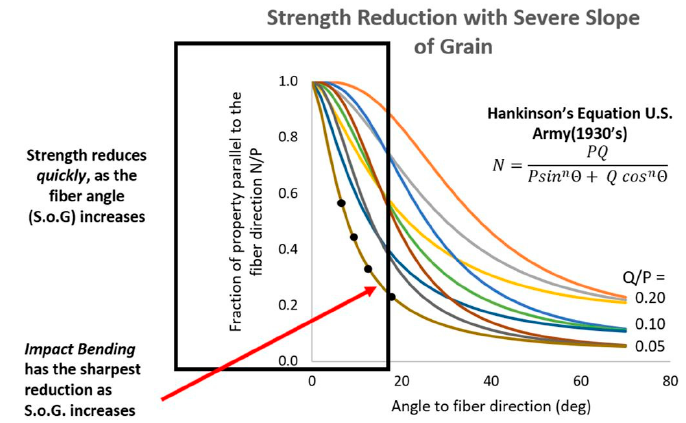
Figure 4. Illustration of Hankinson’s equation [10].